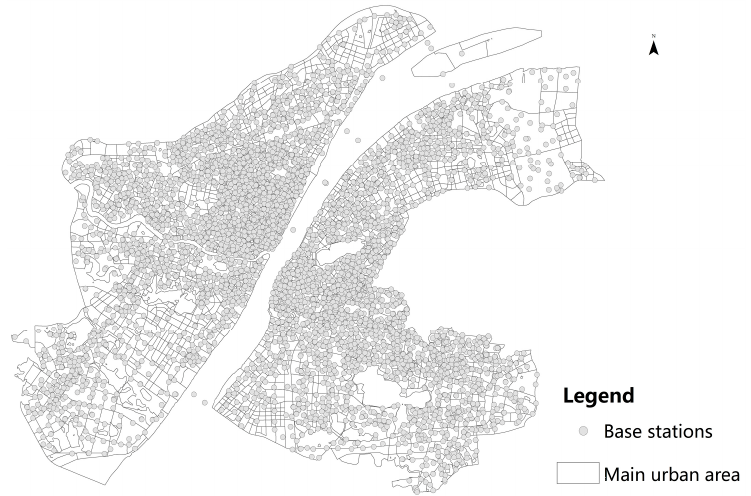
Figure 6. Spatial distribution of base stations in the main urban area of Wuhan.